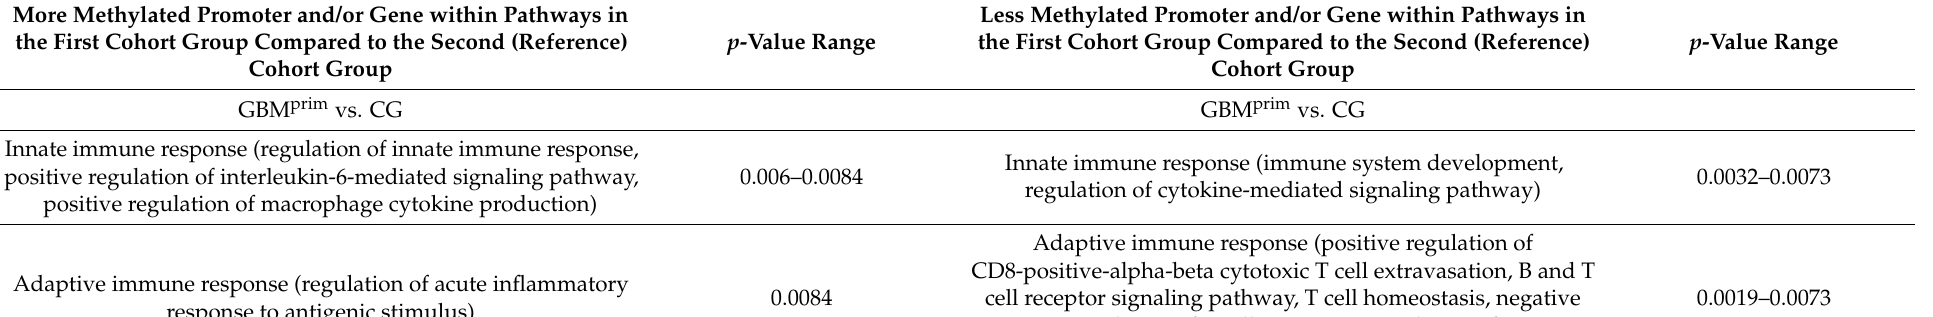
Table 1. Differential methylation in innate and adaptive immune pathways, and in the IL-7 initiated pathway in our cohort: this table presents summary data extracted from the RnBeads GO analyses shown in details in Table S2. For easier review, we here combined the various immune pathway data into three groups: innate and adaptive immune pathways, and separately show data for the IL-7 initiated pathway. While both hypo- and hypermethylation are seen in the GBM prim vs. CG, GBM rec vs. CG and GBM rec vs. GBM prim comparisons of the three immune pathways, suggesting intratumor heterogeneity, it is noteworthy that the shift towards hypermethylation is much more significant during tumor